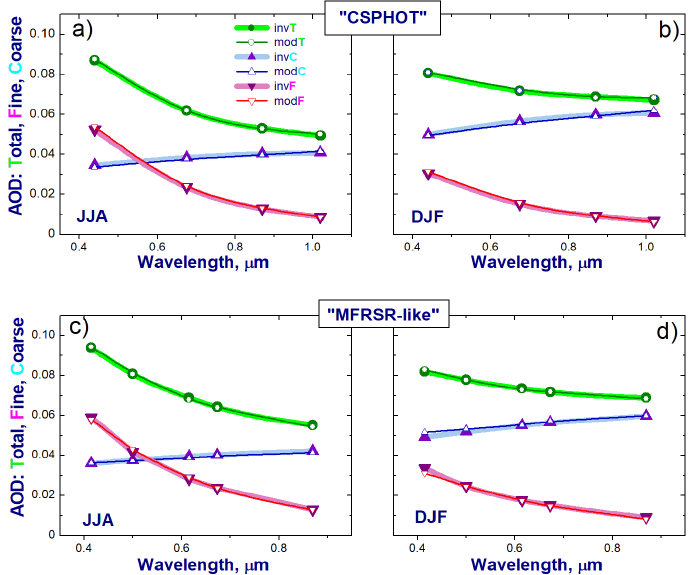
Figure 5. Spectral dependence of the total AOD and its fine and coarse components supplied by the AERONET aerosol inversions (symbol “inv”) and calculations (symbol “mod”) using model SDs estimated for summer ( a , c ) and winter ( b , d ). The calculated AODs represent the “CSPHOT” ( a , b ) and “MFRSR-like” ( c , d ) retrieval schemes (Section 2).